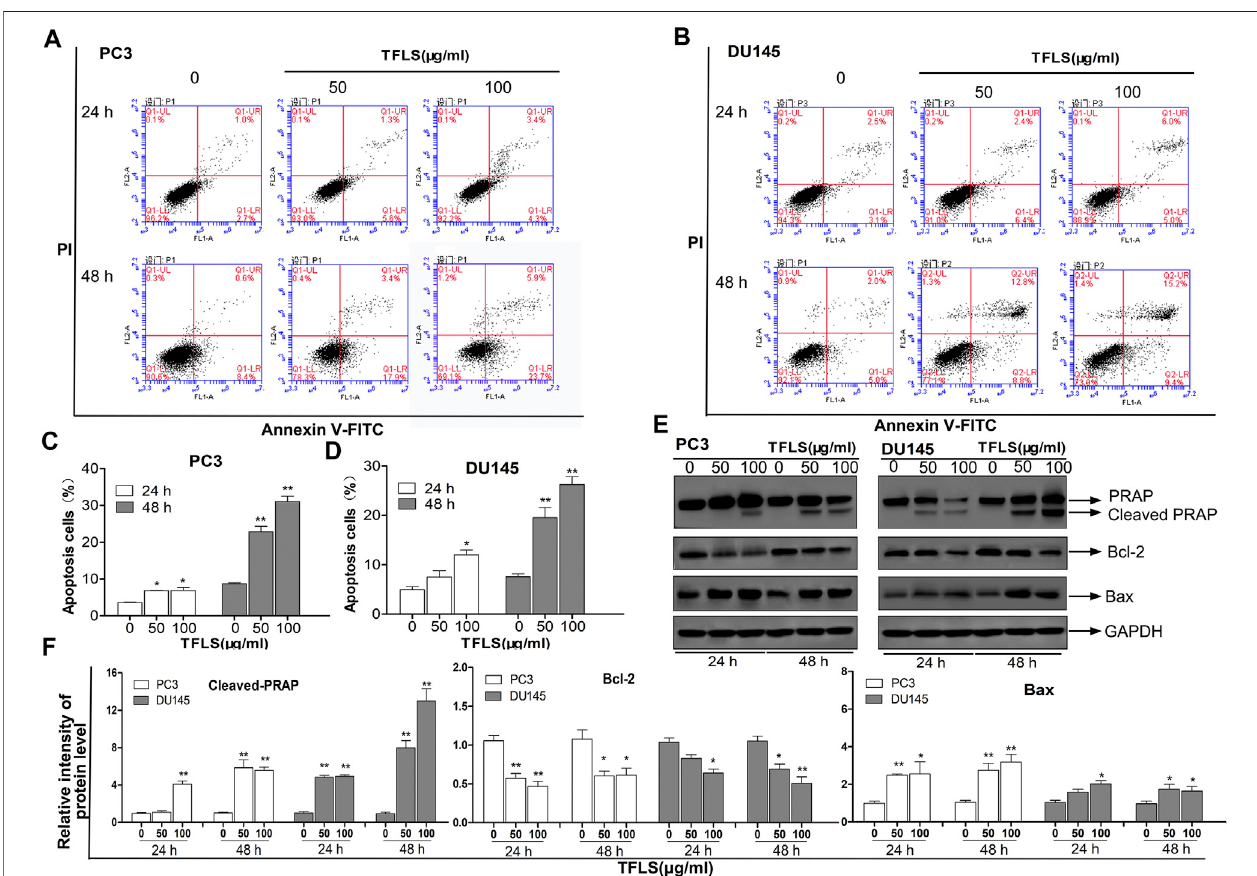
FIGURE 3 | TFLS induced apoptosis in PCa cells. PC3. (A) and DU145. (B) cells were treated with TFLS, the apoptotic cells were analyzed by Annexin V and PI double staining followed by fl ow cytometry analysis. The percentage of early apoptotic cells, late apoptotic cells and overall apoptotic cells were determined. Bar plot of overall apoptotic cells in PC3. (C) and DU145. (D) cells (Annexin V positive cells). (E) The expressions of apoptosis-related proteins in PC3 and DU145 cells were evaluated by Western blot. (F) Bar plots of the relative expressions of apoptosis-related proteins in PC3 and DU145 cells. Data are expressed as mean ± SEM. Compared with control group: * p < 0.05; ** p <